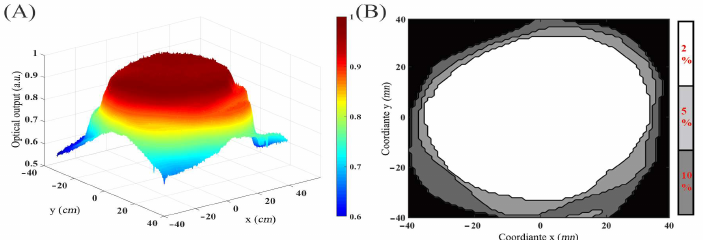
Figure 4. Light uniformity analysis results of the test area: ( A ) normalized light source irradiance distribution; ( B ) contour distribution of light source irradiance.